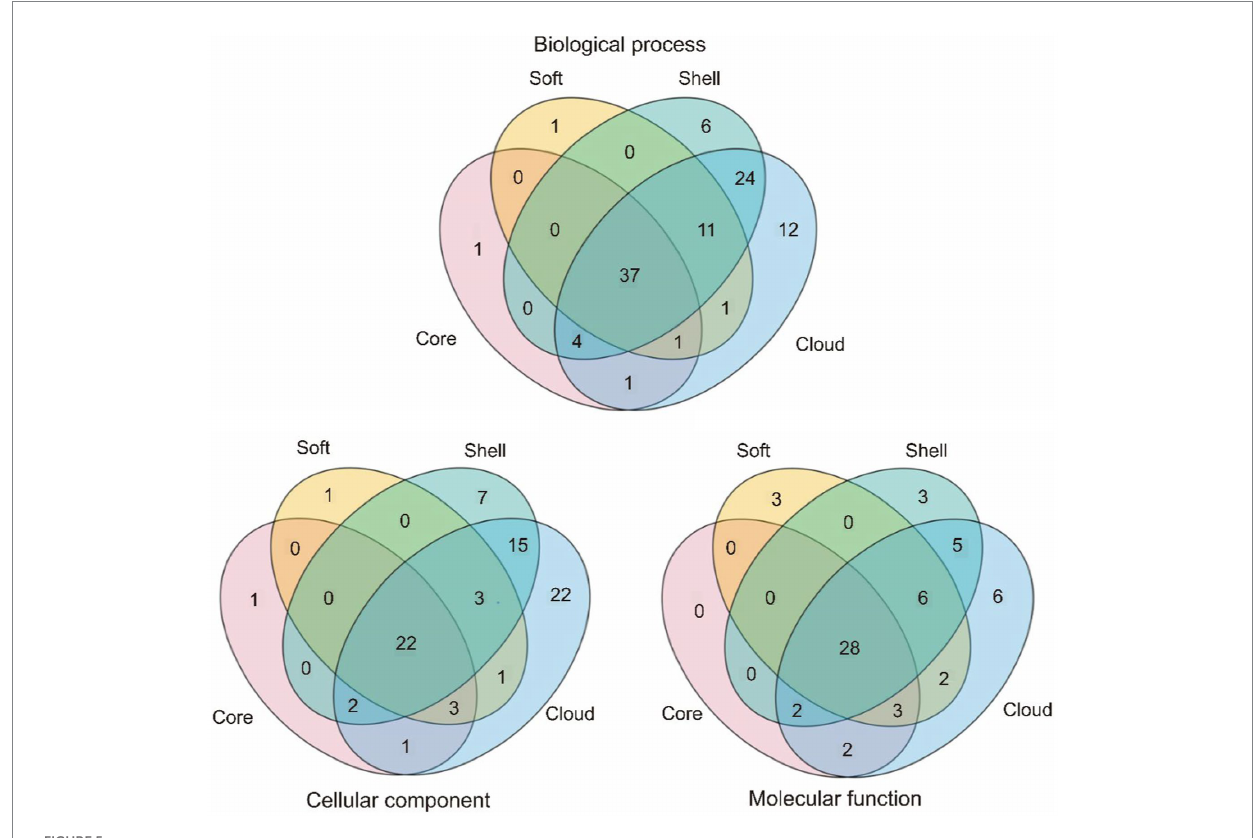
FIGURE 5 Comparison of GO annotation of the core genome and the accessory